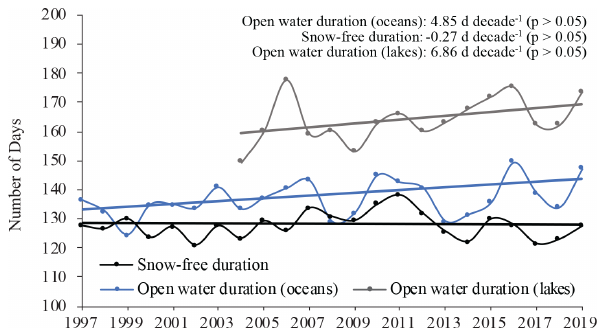
Figure 5. Pan-Arctic open-water duration for oceans (1997–2019), snow-free duration (1997–2019) over land, and open-water duration for lakes (2004–2019). Sen’s slope of the trend and significance are shown. Table 2. Pan-Arctic Spearman rank correlations ( ρ ) for snow and ice phenology dates using the 24km (1997–2019) and 4km (2004– 2019) IMS products. An asterisk (*) represents statistically signifi- cant correlations at the 95% confidence level. rho ( ρ